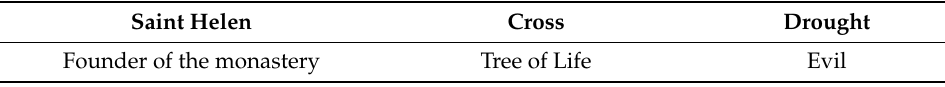
Table 1. Relationship of Iconic Elements at Stavrovouni.